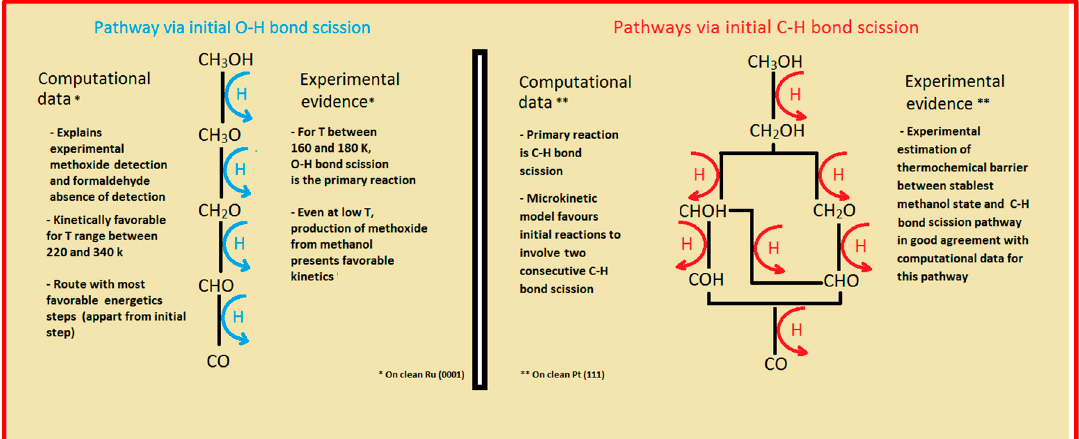
Figure 5. Comparison of different methanol decomposition pathways.